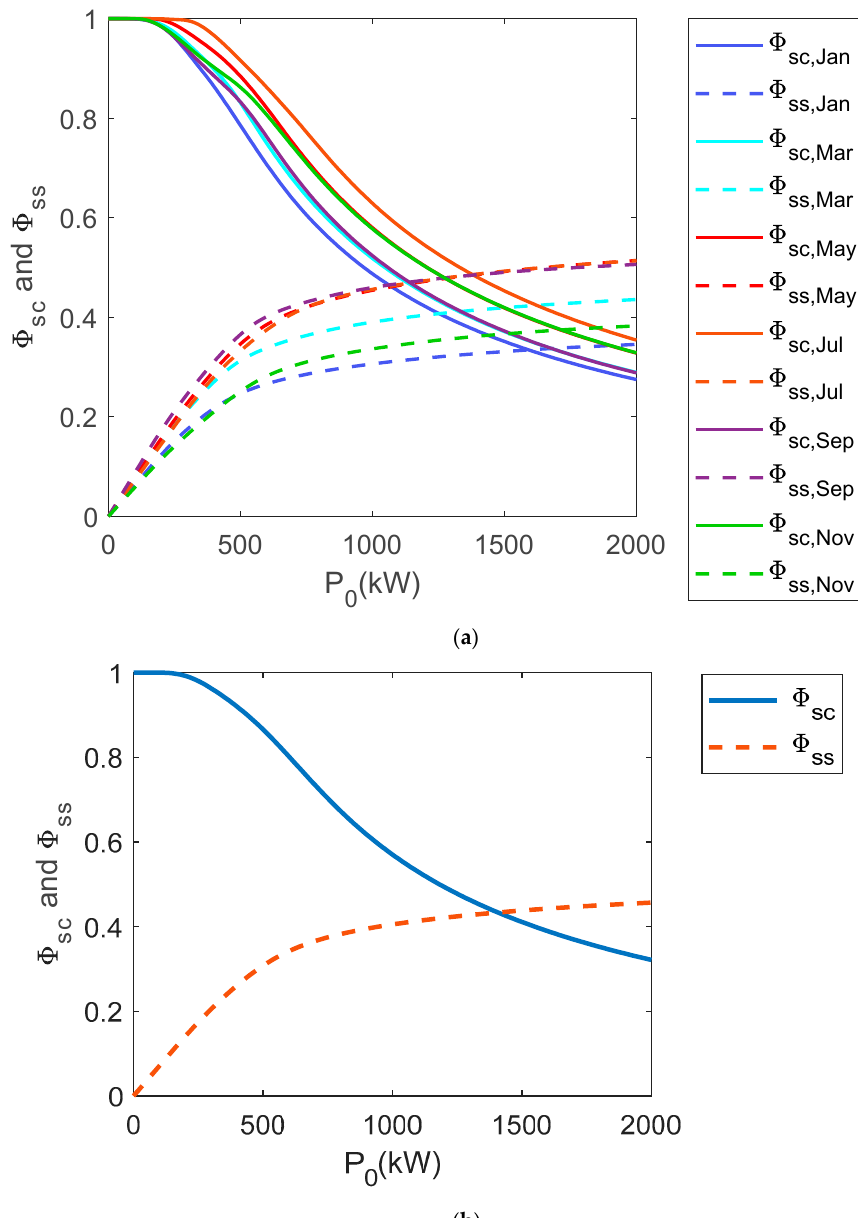
Figure 7. ( a ) Monthly self-consumption and self-sufficiency curves; ( b ) Annual self-consumption and self-sufficiency curves. Industry A.